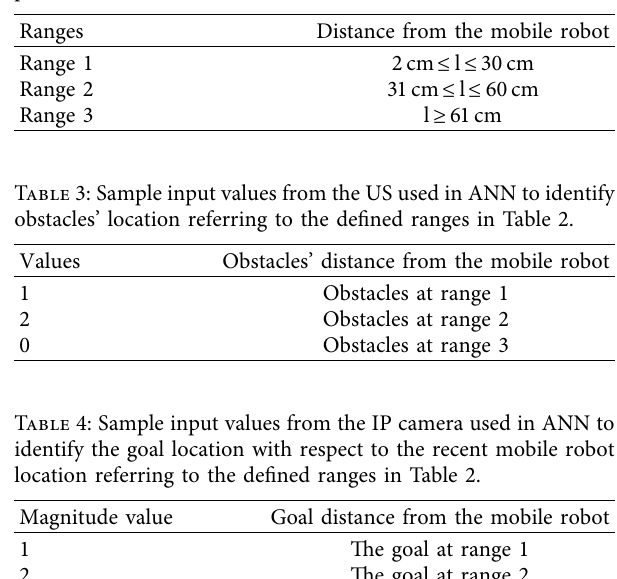
Table 2: Division of workspace referring to the distance from the position of the mobile robot.